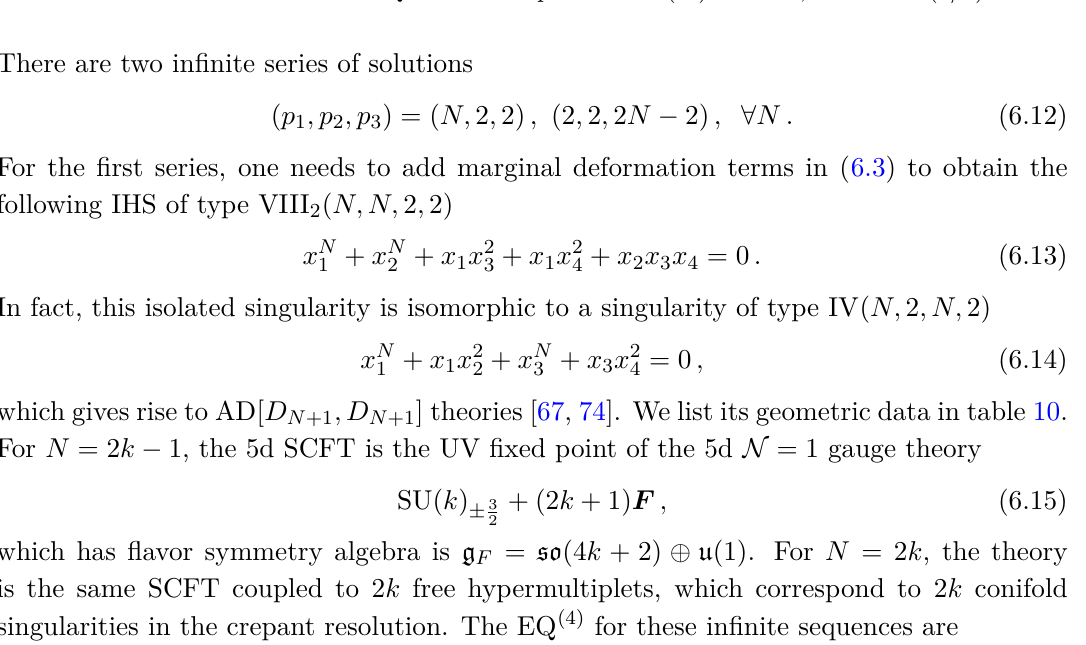
Table 14 . Basic data and EQ (4) for the ‘sporadic’ SU( N ) trinions, continued